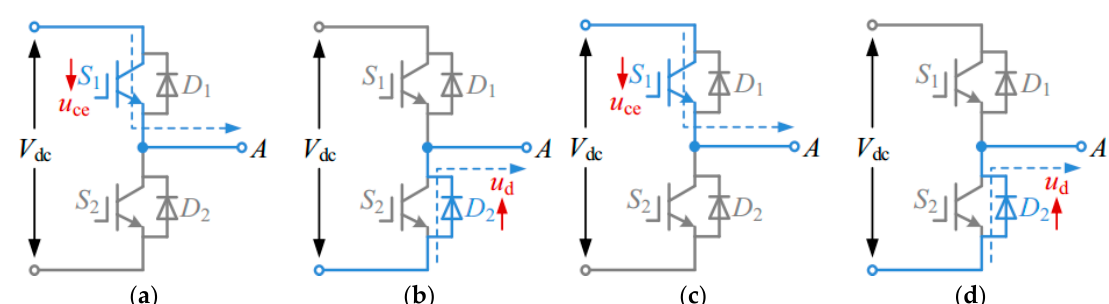
Figure 4. Analysis of di ff erent current flow paths of phase A. ( a ) When i_a > 0 from D1 ( b ) When i_a > 0 from D2 ( c ) When i_a < 0 from D1 ( d ) When i_a < 0 from D2